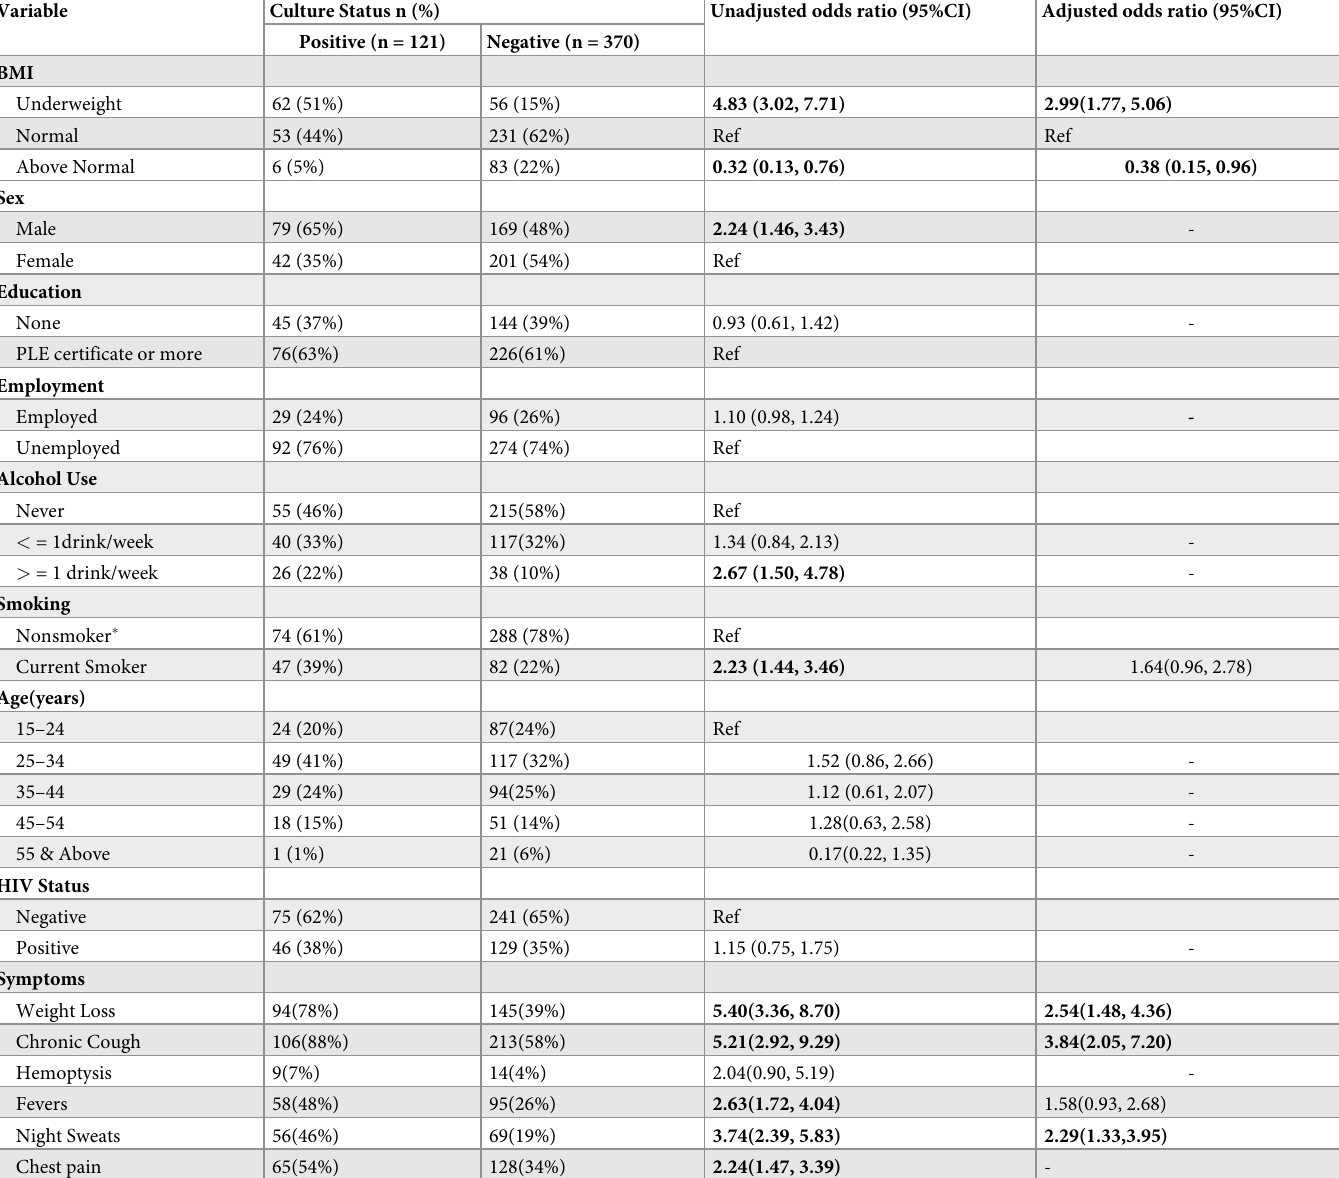
Table 1. Association of clinical and sociodemographic characteristics with TB among presumptive TB patients presenting to four clinics in Kampala, Uganda. (n = 491).